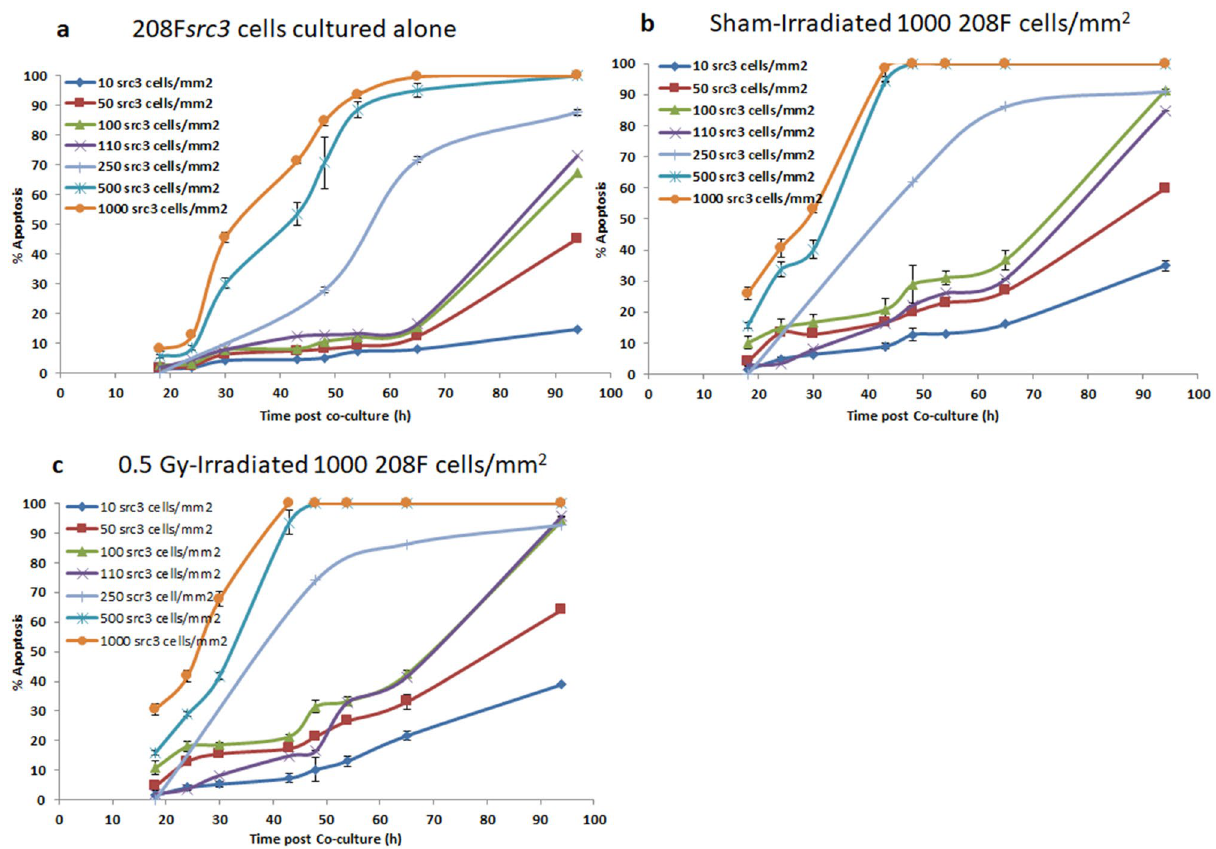
Figure 3. 1000 cells/mm 2 208F cells and varying density of 208F src3 cells. Apoptosis induction in transformed 208F src3 cells seeded at seeding densities of 10, 50, 100,110, 250, 500 and 1000 cells/mm 2 cultured in ( a ) the absence or presence of ( b ) sham- or ( c ) 0.5 Gy γ-irradiated non-transformed 208F cells/mm 2 at a seeding density of 1000 cells/mm 2 . Each data point is a mean value derived from three independent experiments. Error bars represent the standard deviation derived from three independent